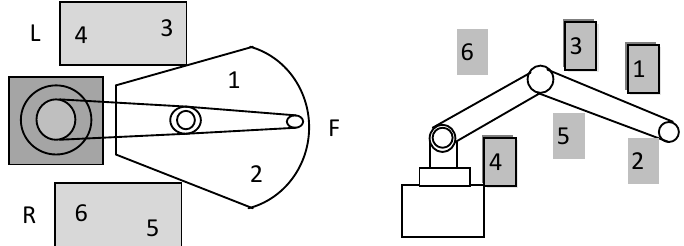
Figure 7. Locations of the fixed point in robot